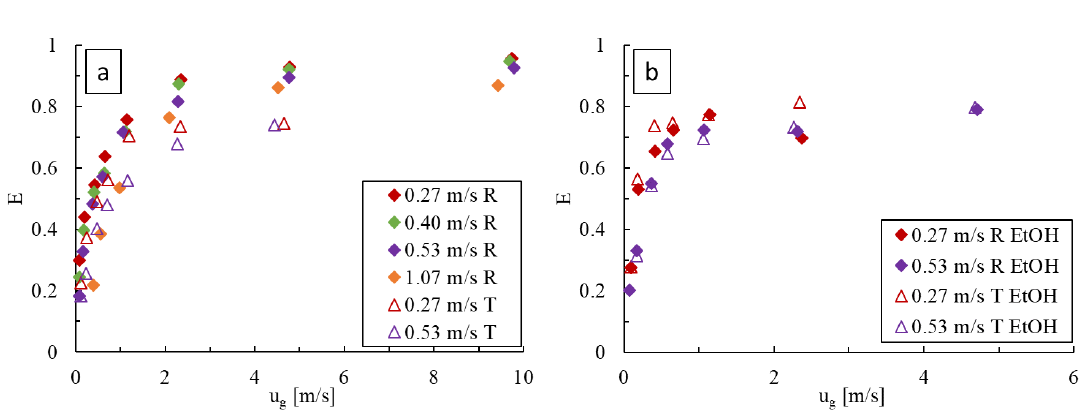
Table 3. 𝑘 𝑙 𝑎 model fits and 95% confidence intervals for LL-Rhombus and LL-Triangle with water and 0.5 wt% aqueous ethanol as the liquid phases over the ranges of 0.565 < 𝜖 < 6.91 W/kg and 0.14 < 𝑢 𝑔 /𝑢 𝑙 < 0.56.